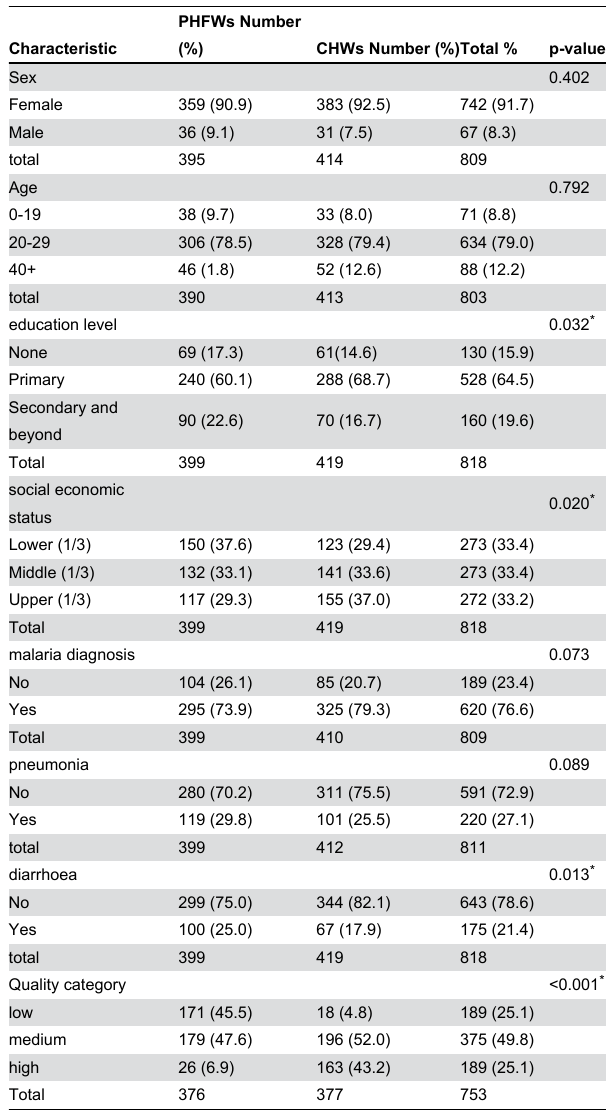
Table 2. Distribution of basic characteristics and overall perceived quality scores between caretakers of children treated by PHFWs and